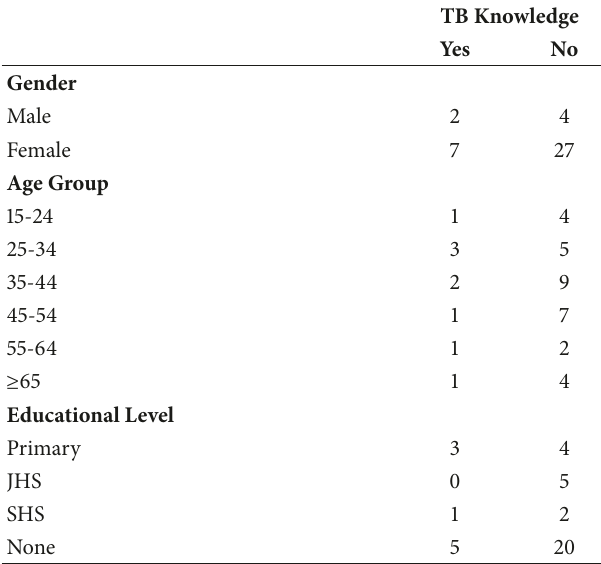
Table 2: Knowledge of TB-infection risk associated with charcoal